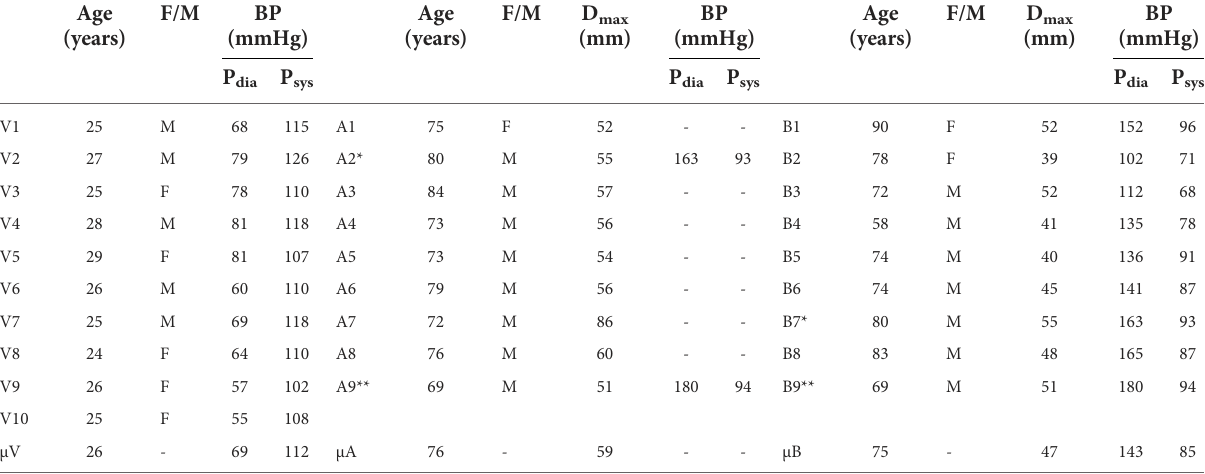
TABLE 1 Summary of the age, gender (female/male), brachial diastolic BP (p dia ) and systolic BP (p sys ) for all 10 healthy volunteers (V1 – V10) and 16